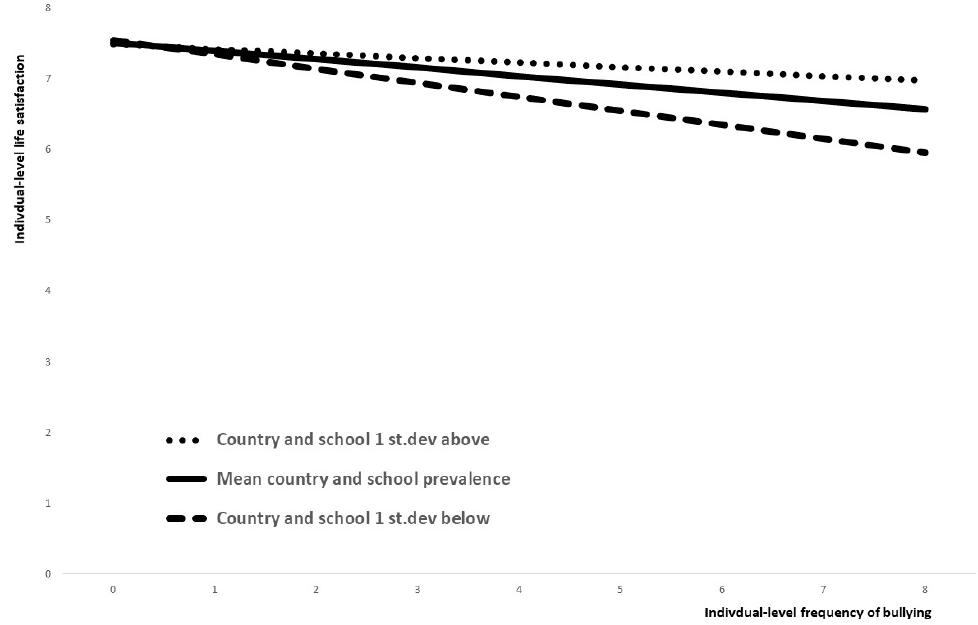
Figure 1. Example of varying intercepts and slopes.